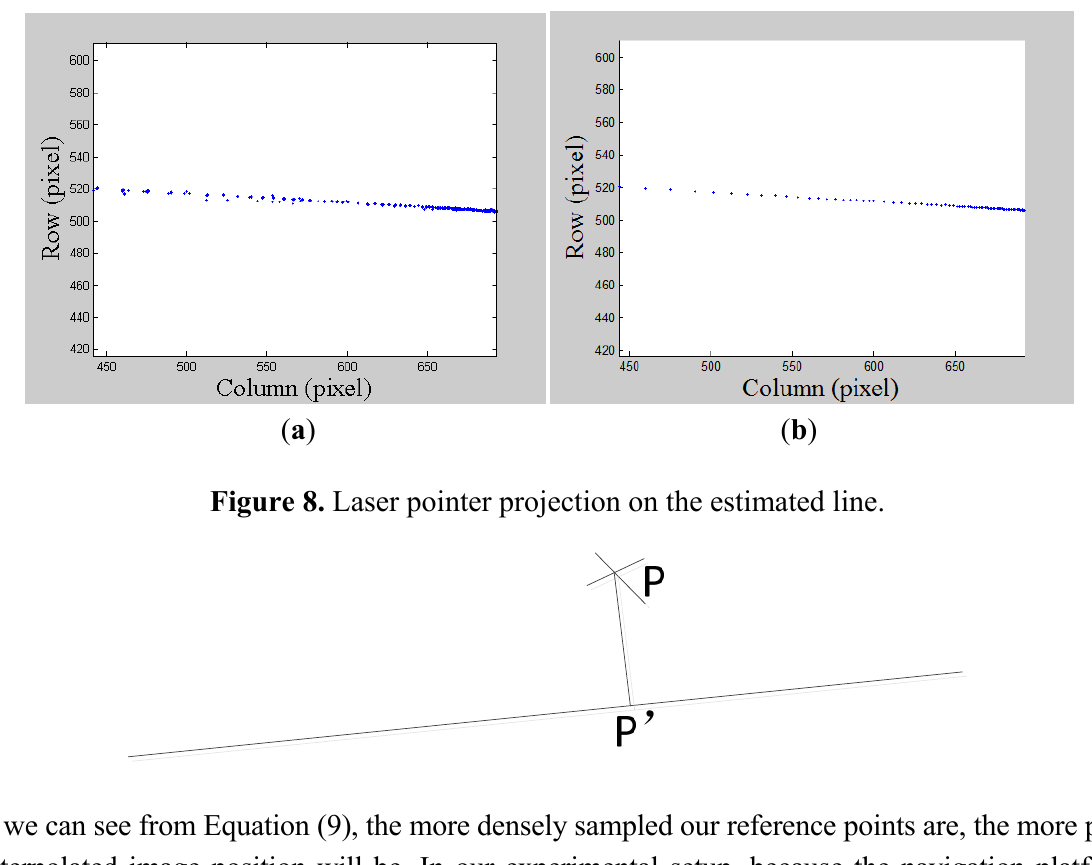
Figure 7. ( a ) Laser pointer projections on an image; ( b ) Laser pointer projections on an image with gross error removed after MLESAC.